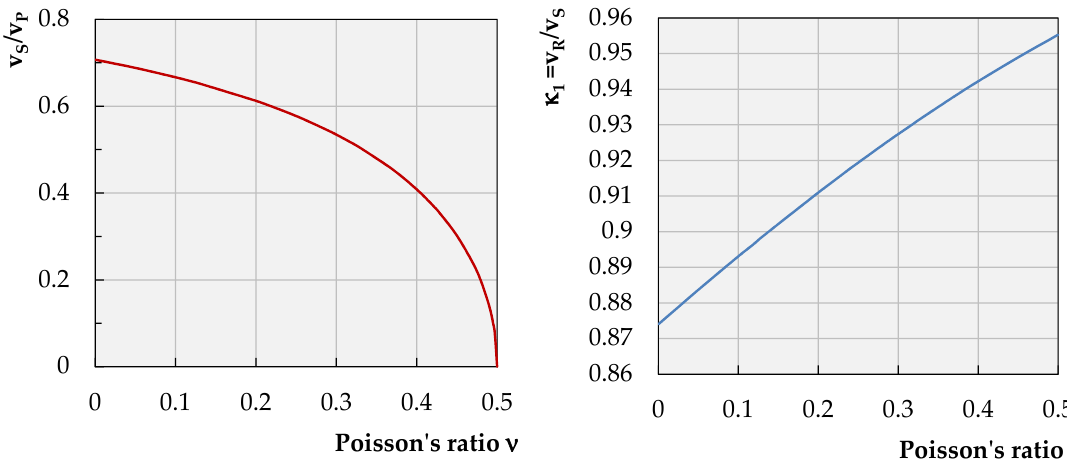
Figure 6. Relationship between the Poisson’s ratio values and velocities of waves R, P and S.